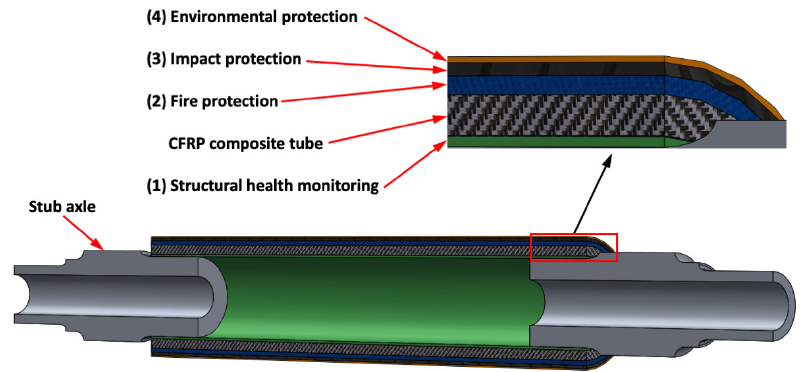
Figure 2. Cross-section of a design concept for the hybrid metallic-composite railway axle with a structural composite core and coaxial skins (Note: tether mechanism not shown).